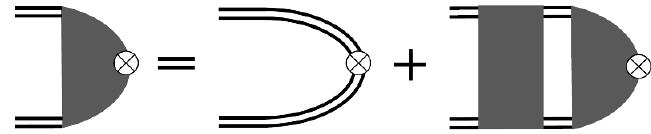
Figure 15 . The integral equation for bulk viscosity in the SU( M ) theory.